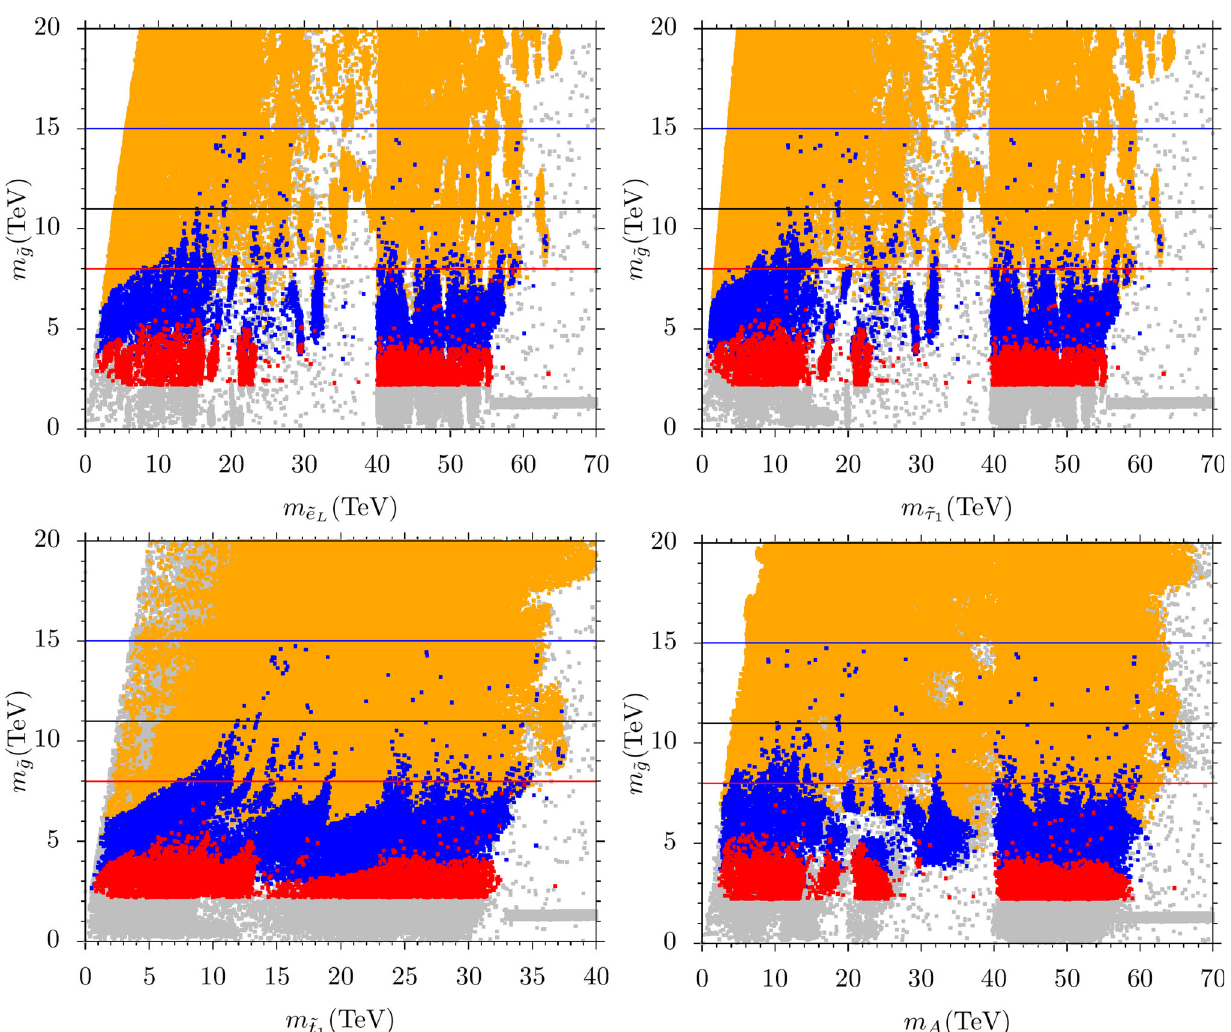
Fig. 3 The gluino mass versus the left-handed slepton mass, light stau mass, light stop mass, and CP-odd Higgs boson mass. The color coding is the same as in Fig. 2